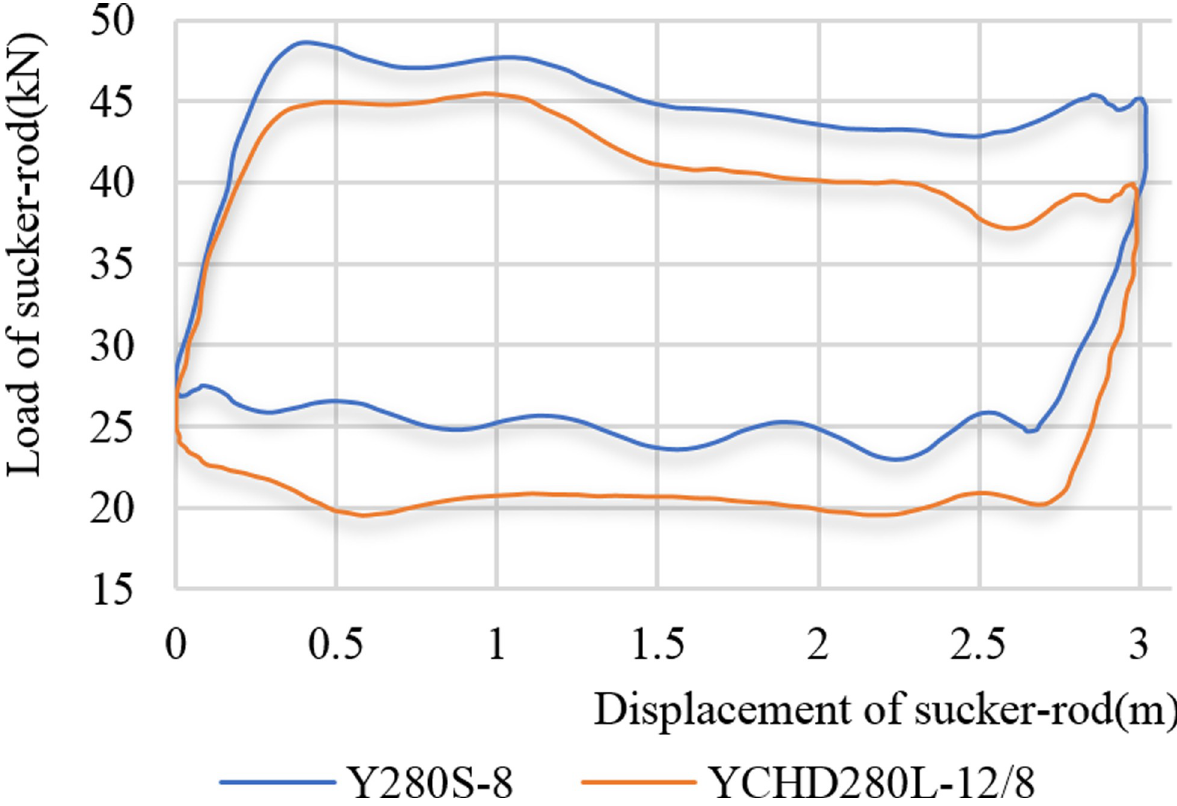
Fig 15. Comparison of the suspension dynamometer diagram curve at 6 times.